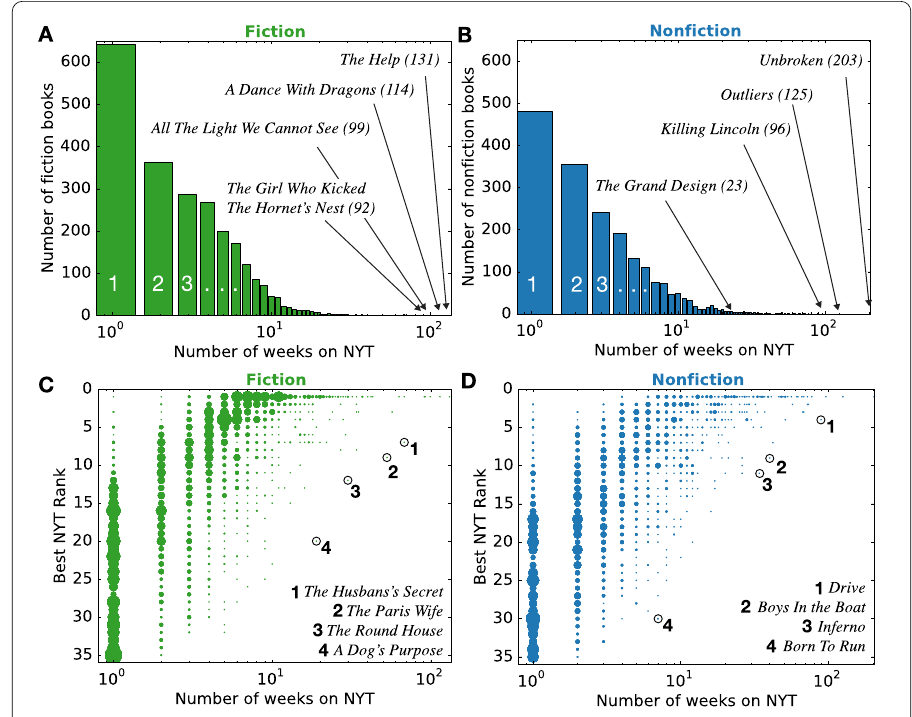
Figure 2 Longevityofbestsellers . Distribution of ( A ) fiction and ( B ) nonfiction bestsellers based on the number of weeks they stayed on the list. The number of weeks is shown in logarithmic scale to account for both the large number of short stays and the few exceptionally longer presence. We marked on the first columns the corresponding linear scale numbers for clarity. The best rank a book achieved on the New York Times ( C ) fiction and ( D ) nonfiction bestseller list vs. the number of weeks it stayed on the list. The size of the dots indicates the number of books with the same attributes. Overall, the better a book’s best ranking, the higher is its probability of staying longer in the